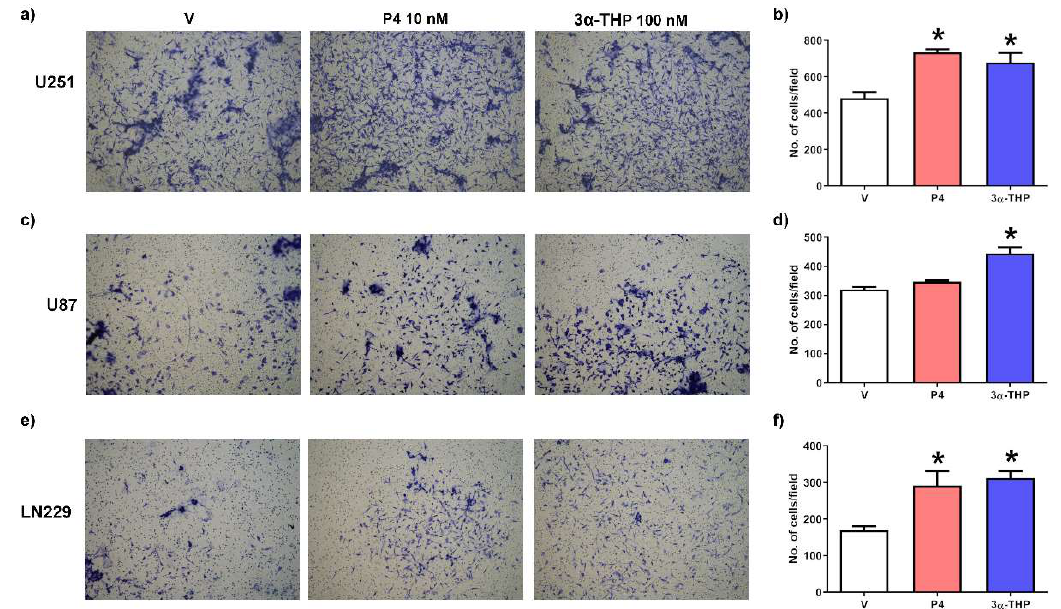
Figure 2. Effect of 3α-THP on the invasion of human GB cell lines. Cells were treated with vehicle (V; ethanol, 0.1% in the medium), P4 (10 nM), and 3α-THP (100 nM) for 24 h. Representative images of ( a ) U251; ( c ) U87, and ( e ) LN229 invasion assays. All photographs were taken at 10× augment. Graphs of the invading cells number per field: ( b ) U251; ( d ) U87; and ( f ) LN229 cell lines. Each column represents the mean ± SEM. n = 3 for all cell lines evaluated; * p < 0.05 vs. V.